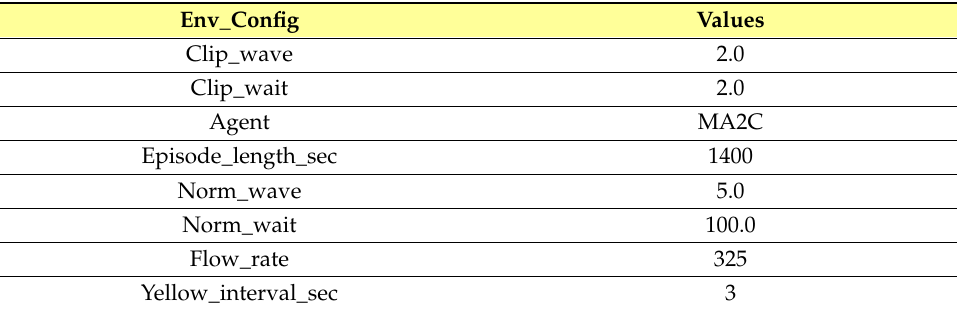
Table 3. The environment configuration.